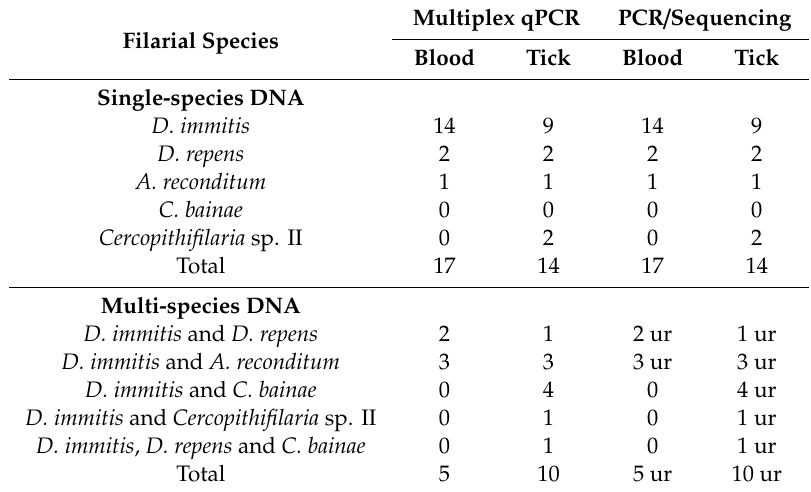
Table 5. Distribution of Positive Samples Detected by Each Molecular Assay (i.e., Multiplex qPCRs and PCR/Sequencing) from Canine Blood and Tick Samples.